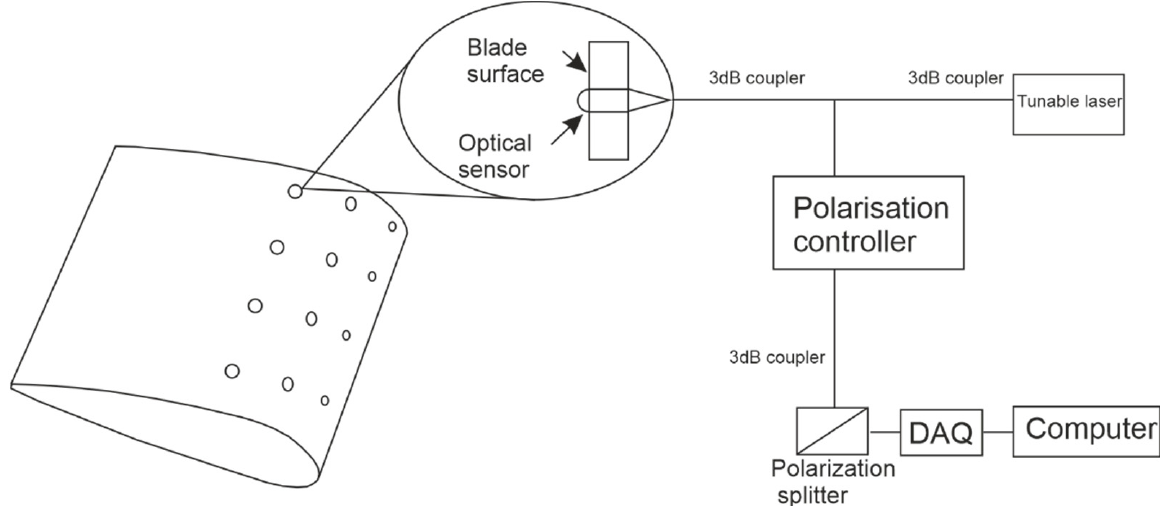
Figure 1. The optical frequency domain reflectometry ice detector [12,44].